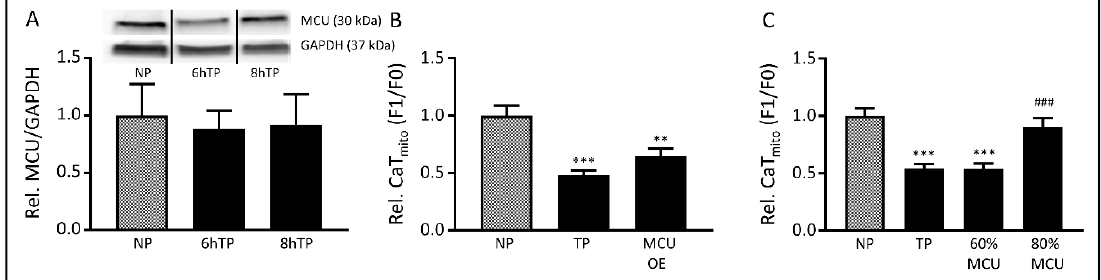
Figure 5. Tachypacing-induced changes are due to MCU expression. ( A ) Top panel represent Western blot of MCU and GAPDH, lower panel reveals quantified data of MCU normalized for GAPDH during normal-pacing (NP) or tachypacing (TP). ( B ) Quantified data of mitochondrial calcium transient (CaT mito ) amplitudes of HL-1 atrial cardiomyocytes either non-transfected or transfected with MCU, generating MCU overexpression (MCU OE) after NP or 6h tachypacing (black bars). ( C ) Quantified data of CaT mito amplitudes of HL-1 atrial cardiomyocytes either non-transfected or transfected with MCU siRNA, generating MCU knockdown so that either 60% or 80% or MCU is still present after NP or 6h tachypacing (black bars). ** p < 0.01, *** p < 0.001 vs. NP, ### p < 0.001 vs. TP.